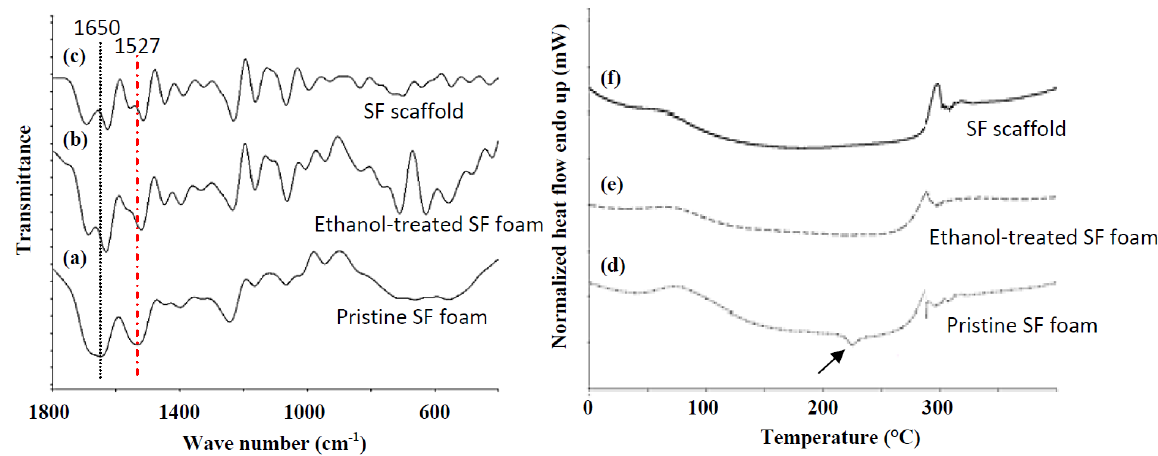
Figure 2. FTIR spectra (Lines a – c ) and DSC (differential scanning calorimetry) thermograms (Lines d – f ) of SF samples processed under different conditions. ( a , d ) Pristine SF foam; ( b , e ) ethanol-treated SF foam; ( c , f ) SF scaffold. The characteristic peaks of the SF scaffold were identical to ethanol-treated foam, but distinctive from those of pristine SF foam, as shown by the peak shifts of amide I and II (lines) in the FTIR spectra and the absence of an exothermic peak in the DSC thermograms